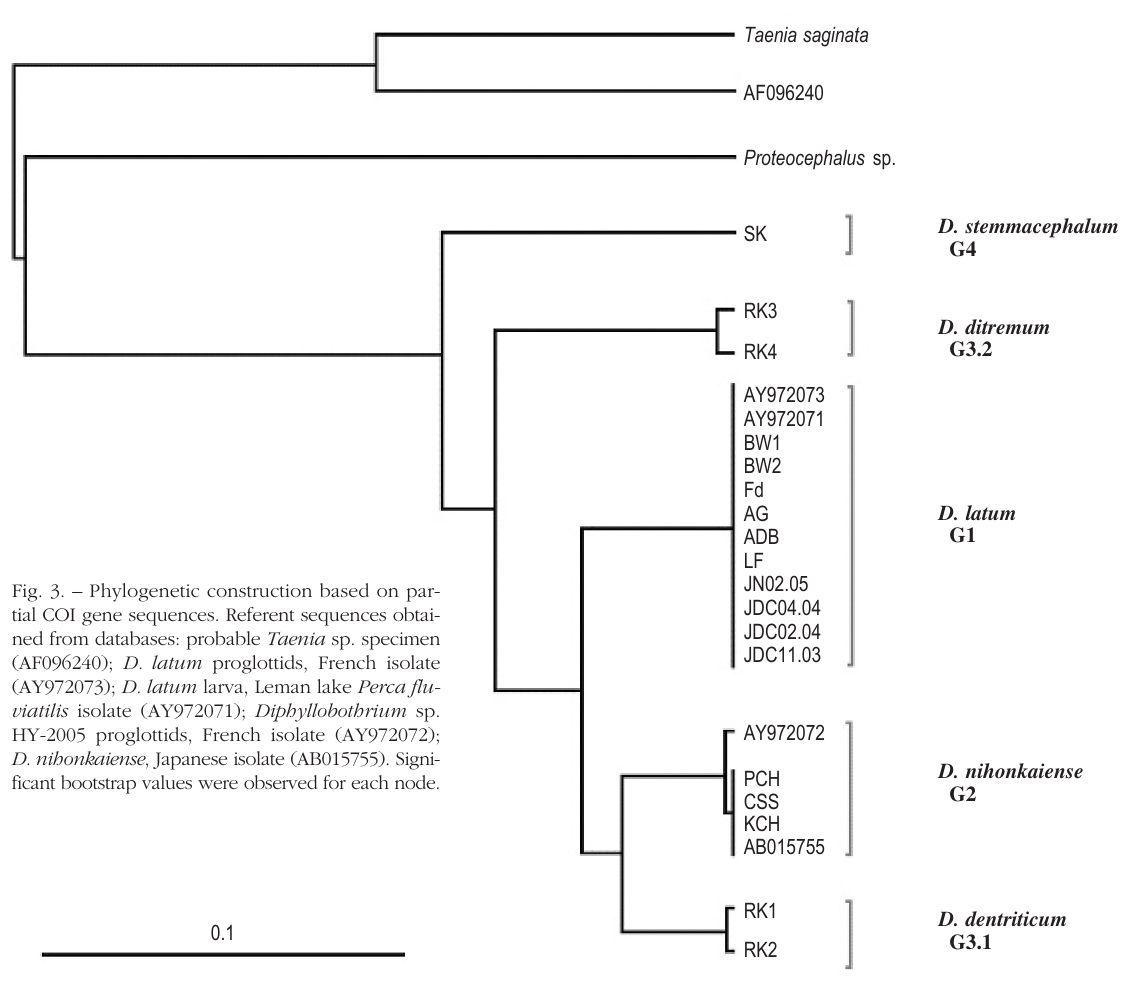
Fig. 3. – Phylogenetic construction based on par- tial COI gene sequences. Referent sequences obtai- ned from databases: probable Taenia sp. specimen (AF096240); D. latum proglottids, French isolate (AY972073); D. latum larva, Leman lake Perca flu- viatilis isolate (AY972071); Diphyllobothrium sp. HY-2005 proglottids, French isolate (AY972072); D. nihonkaiense , Japanese isolate (AB015755). Signi- ficant bootstrap values were observed for each